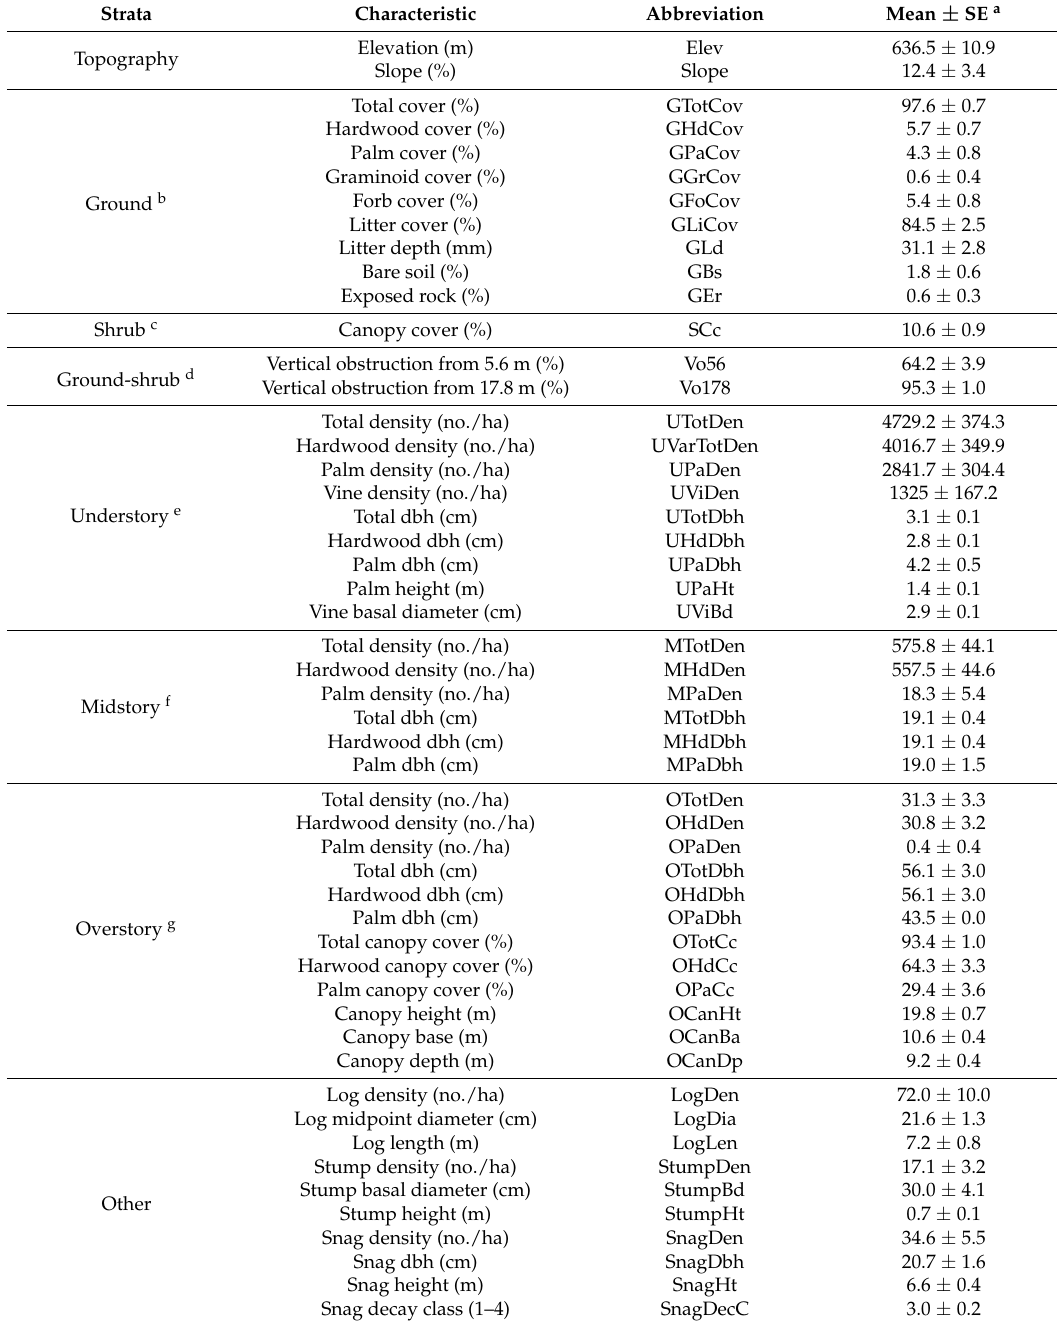
Table 1. Forest structure and composition of the Chiquibul Forest Reserve (CFR), Belize, Central America, in summer